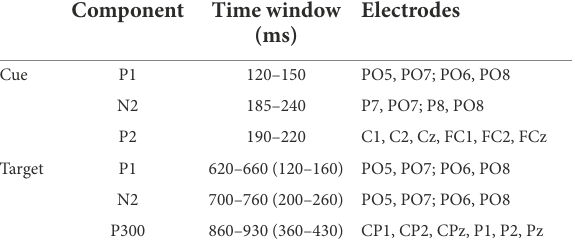
TABLE 2 The time windows and selected electrodes for ERP components of the cue and the target. Component